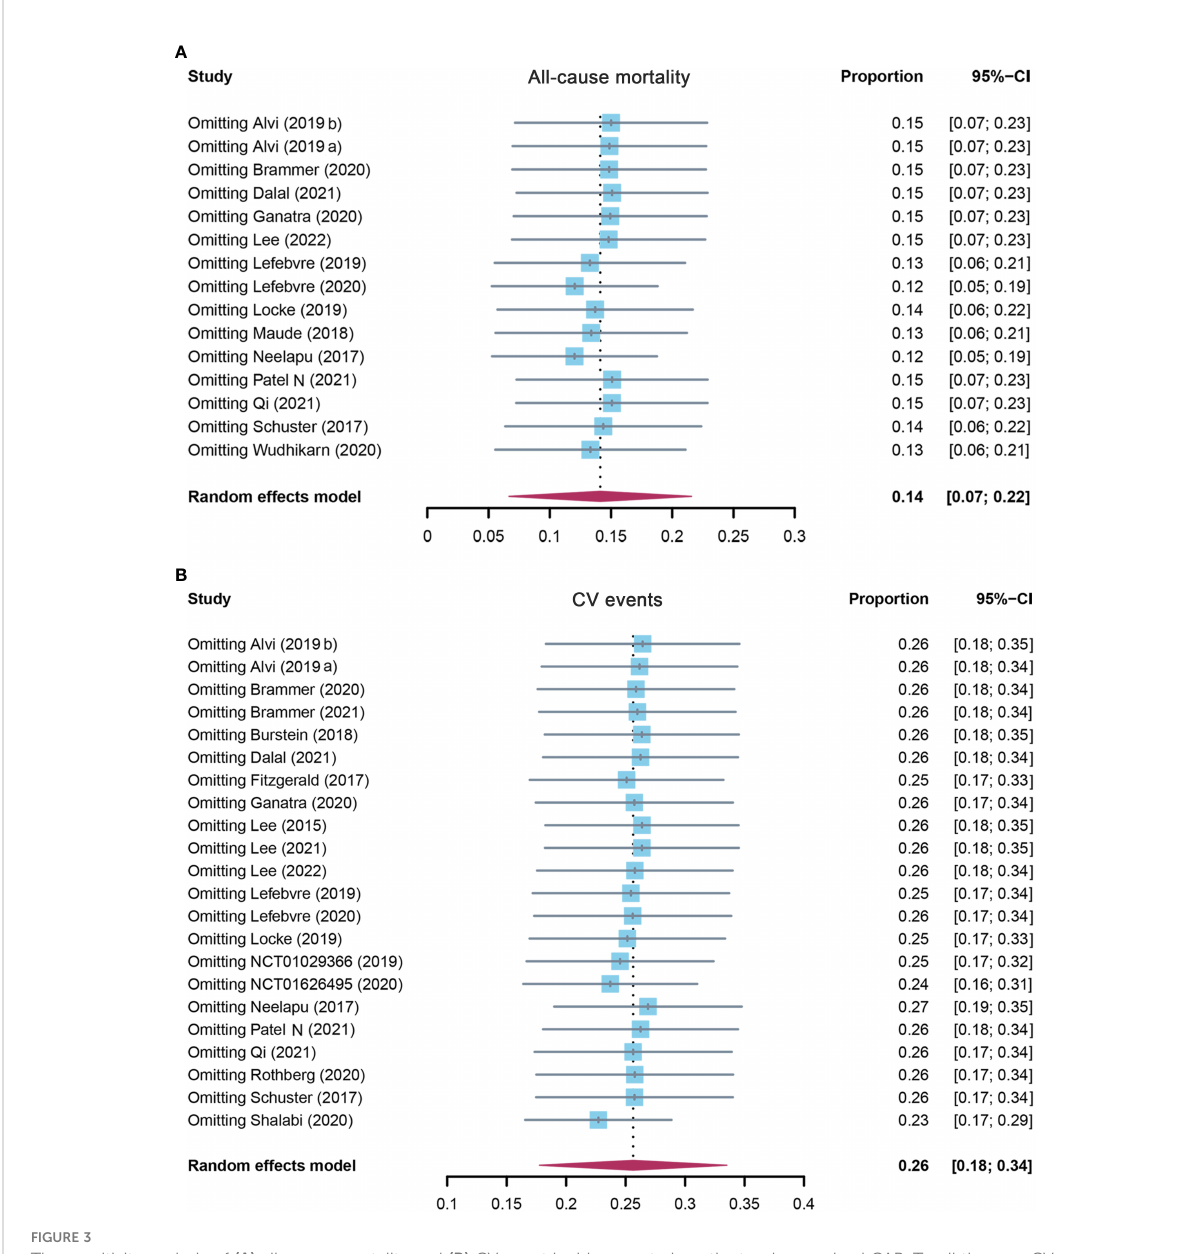
(Figure 2B). In the subgroup analysis, the incidence rate of CV events was 26.0% (95% CI: 0.156 – 0.365) for the CD19 subgroup, 22.7% (95% CI: 0.078 – 0.454) for the BCMA subgroup, and 25.4% (95% CI: 0.115 – 0.394) for others